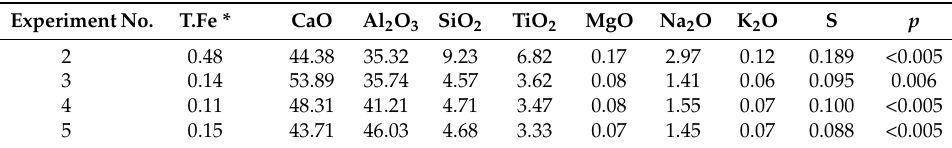
Table 5. Chemical composition of the slag after smelting separation (mass %). Experiment No. T.Fe